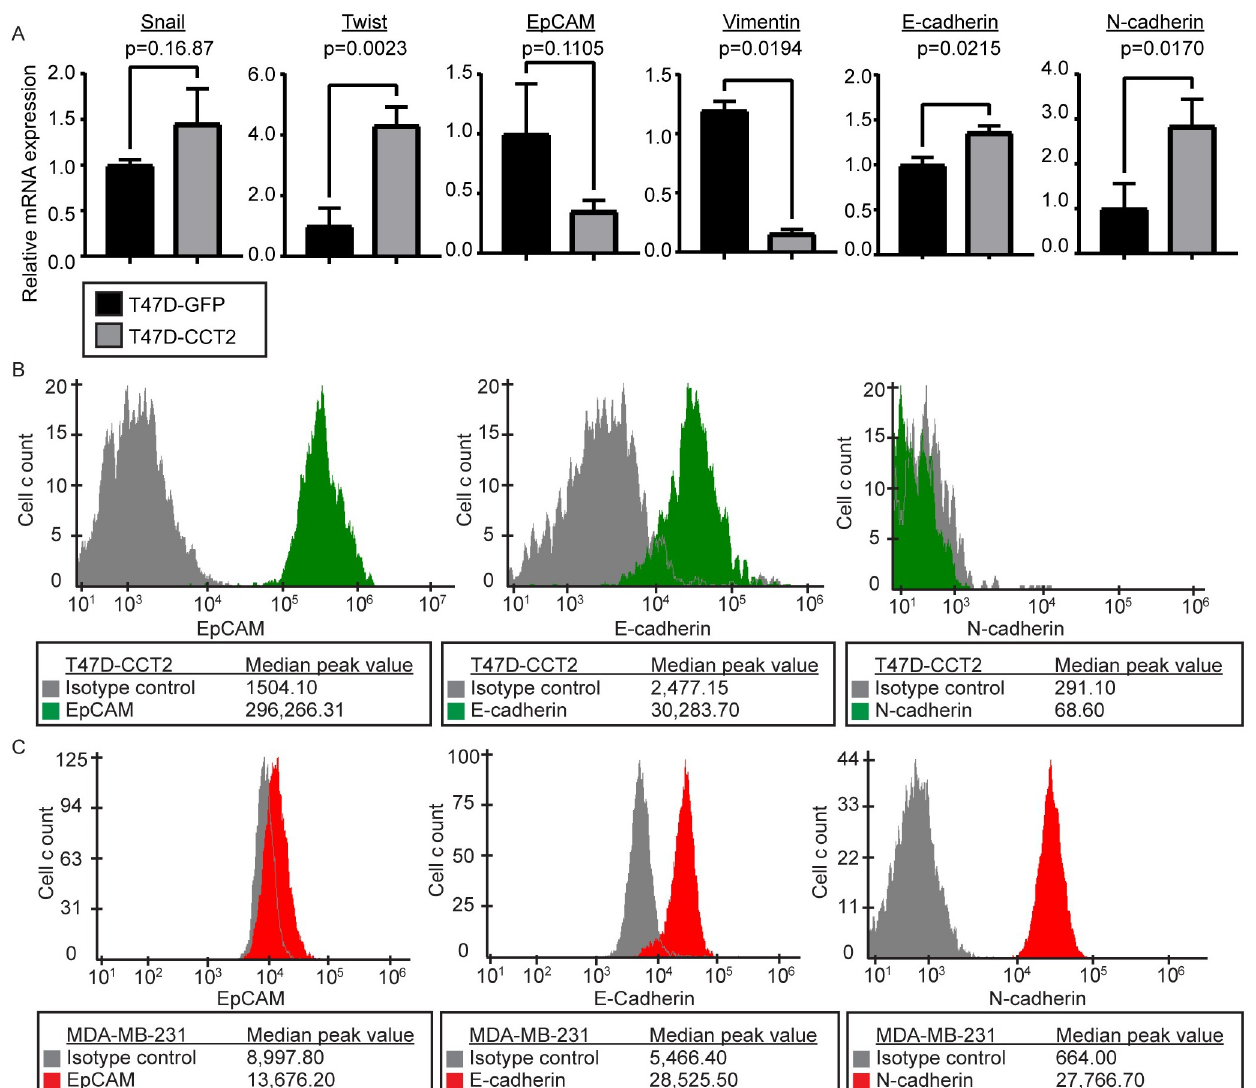
Fig 3. EpCAM, vimentin, E-cadherin, and N-cadherin expression in MDA-MB-231 and T47D cells. (A) RT-PCR data comparing lentiviral control (T47D-GFP) (black) with T47D-CCT2 (grey) for expression of EMT genetic markers: SNAIL and TWIST , epithelial markers: EpCAM and E-cadherin , and mesenchymal markers: vimentin and N-cadherin . p-values are shown on the graph. (B) Flow cytometry data detecting surface expression of EpCAM, E- cadherin, and N-cadherin protein in T47D-CCT2 cells (green) compared to isotype controls (grey). (C) Flow cytometry data detecting surface expression of EpCAM, E-cadherin, and N-cadherin proteins in MDA-MB-231 cells (red) compared to isotype controls (grey). All experiments were performed in duplicate.